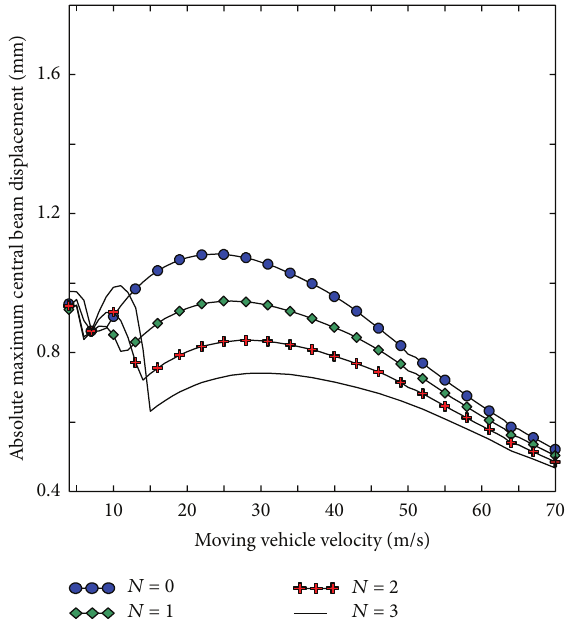
Figure 9: The maximum displacement of the beam at mid-span versusthevelocityofthemovingvehiclewithoneandtwo( 𝑁 = 1, 2 ) absorbers attached.